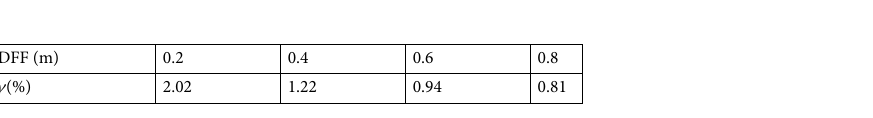
Table 4. The error indexes corresponding to different